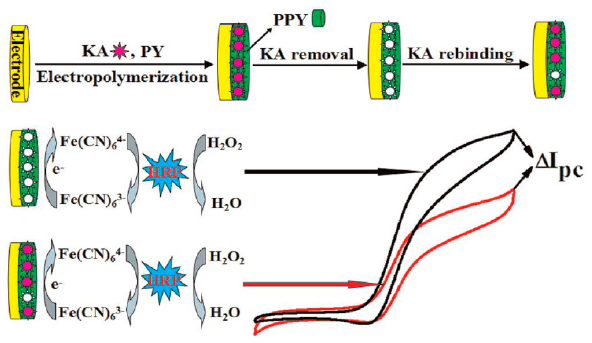
Figure 9. Preparation scheme of a kanamycin MIP using pyrrole (PPY) as a monomer, the signal is amplified by electro-enzymatic recycling of ferricyanide. Reprinted by permission from [127].